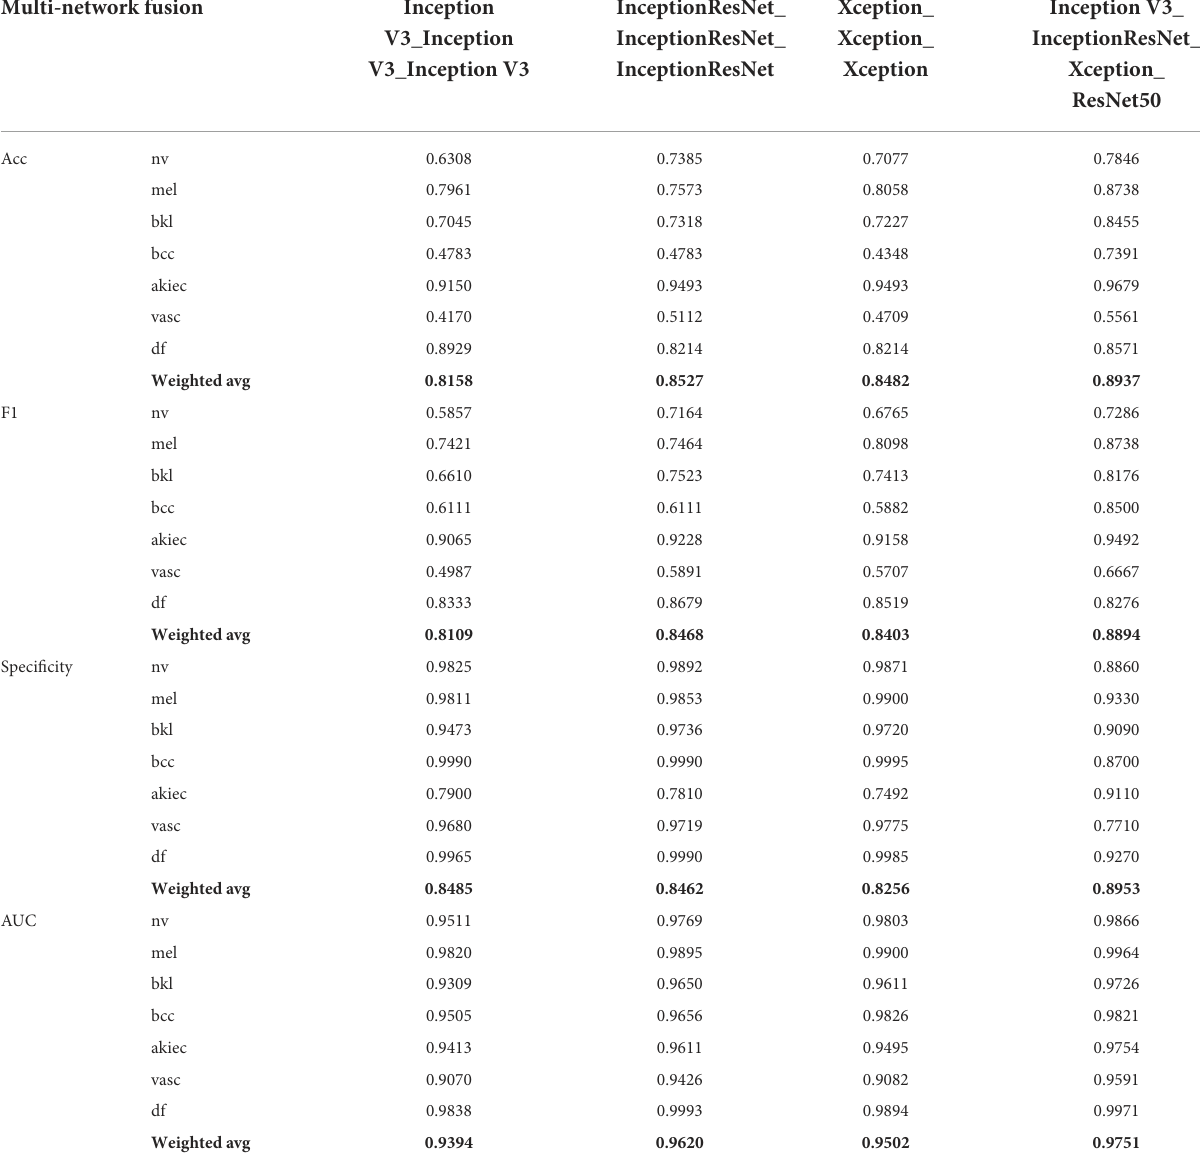
TABLE 7 The influence of fusion of multiple base classifiers on evaluation